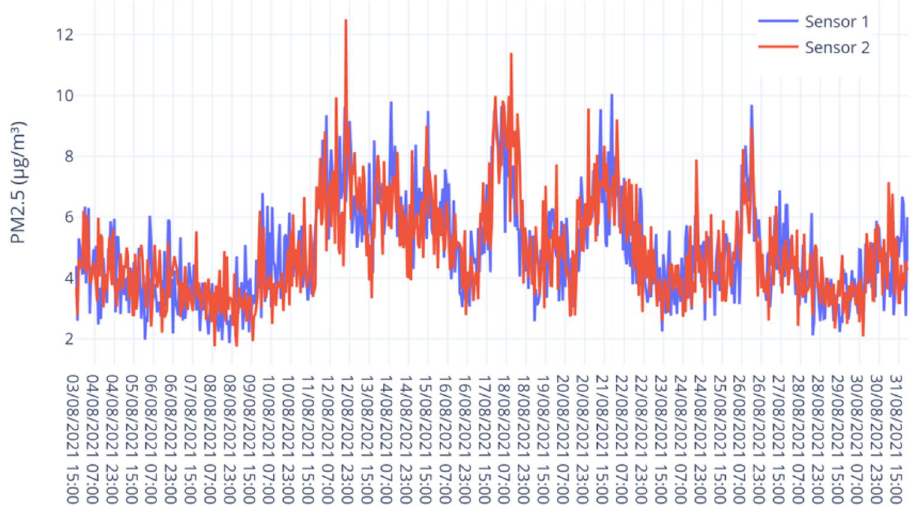
Figure 7. Line plot of PM2.5 data obtained from two collocated CoSense Units.